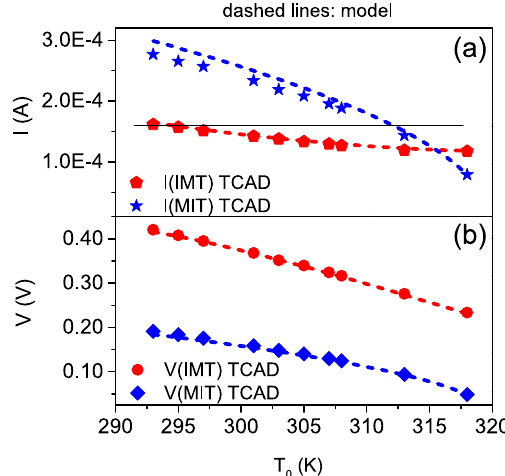
Figure 5. ( a ) I IMT (red pentagons), I MIT (blue stars) and ( b ) V IMT (red circles), V MIT (blue diamonds) as derived from TCAD simulations. The dashed lines are the currents and voltages as calculated from the proposed model. In ( a ), the black solid line is drawn parallel to T 0 axis. It intersects the I IMT line at T 0 = 293 K, and the I MIT line at about T 0 = 312